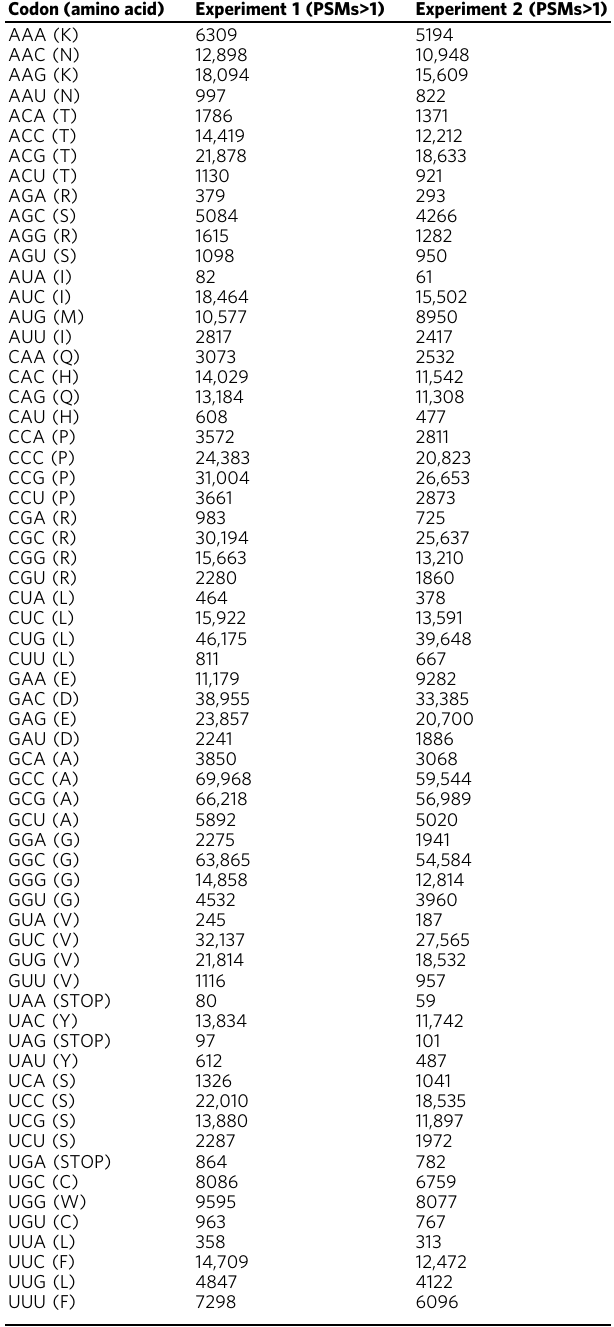
Experiments 1 and 2 were technical replicates. STOP represents a termination